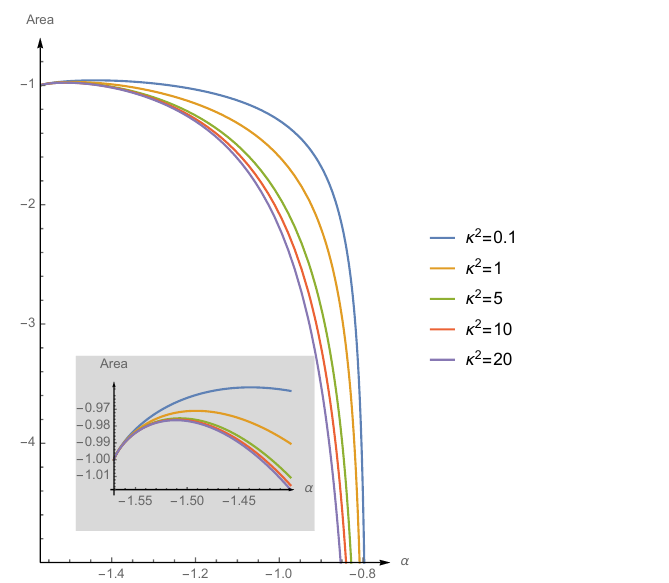
Figure 14. The behavior of the distance from the defect as a function of (cid:11) (cid:17) arctan( m ) at (cid:31) = (cid:25) is not qualitatively di(cid:11)erent from the one obtained for other values of the angle greater than (cid:31) s . All the curves display a maximum.